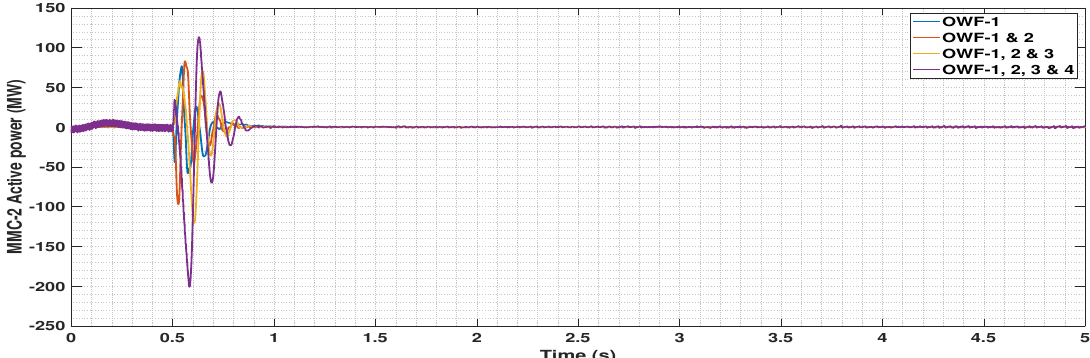
Figure 23. Active power in MMC-2 bus upon connecting all OWFs with 50 MW generation each.